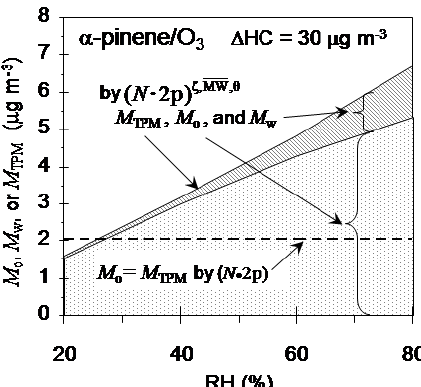
Fig. 6. M o , M w , and M TPM by the (N. 2p ) ζ, MW ,θ approach using the CP-Wilson.1 method for the activity coefficients for the α -pinene/O 3 products, with 1 HC=30µgm − 3 ; for comparison, M o = M TPM by the N · 2p approach is also